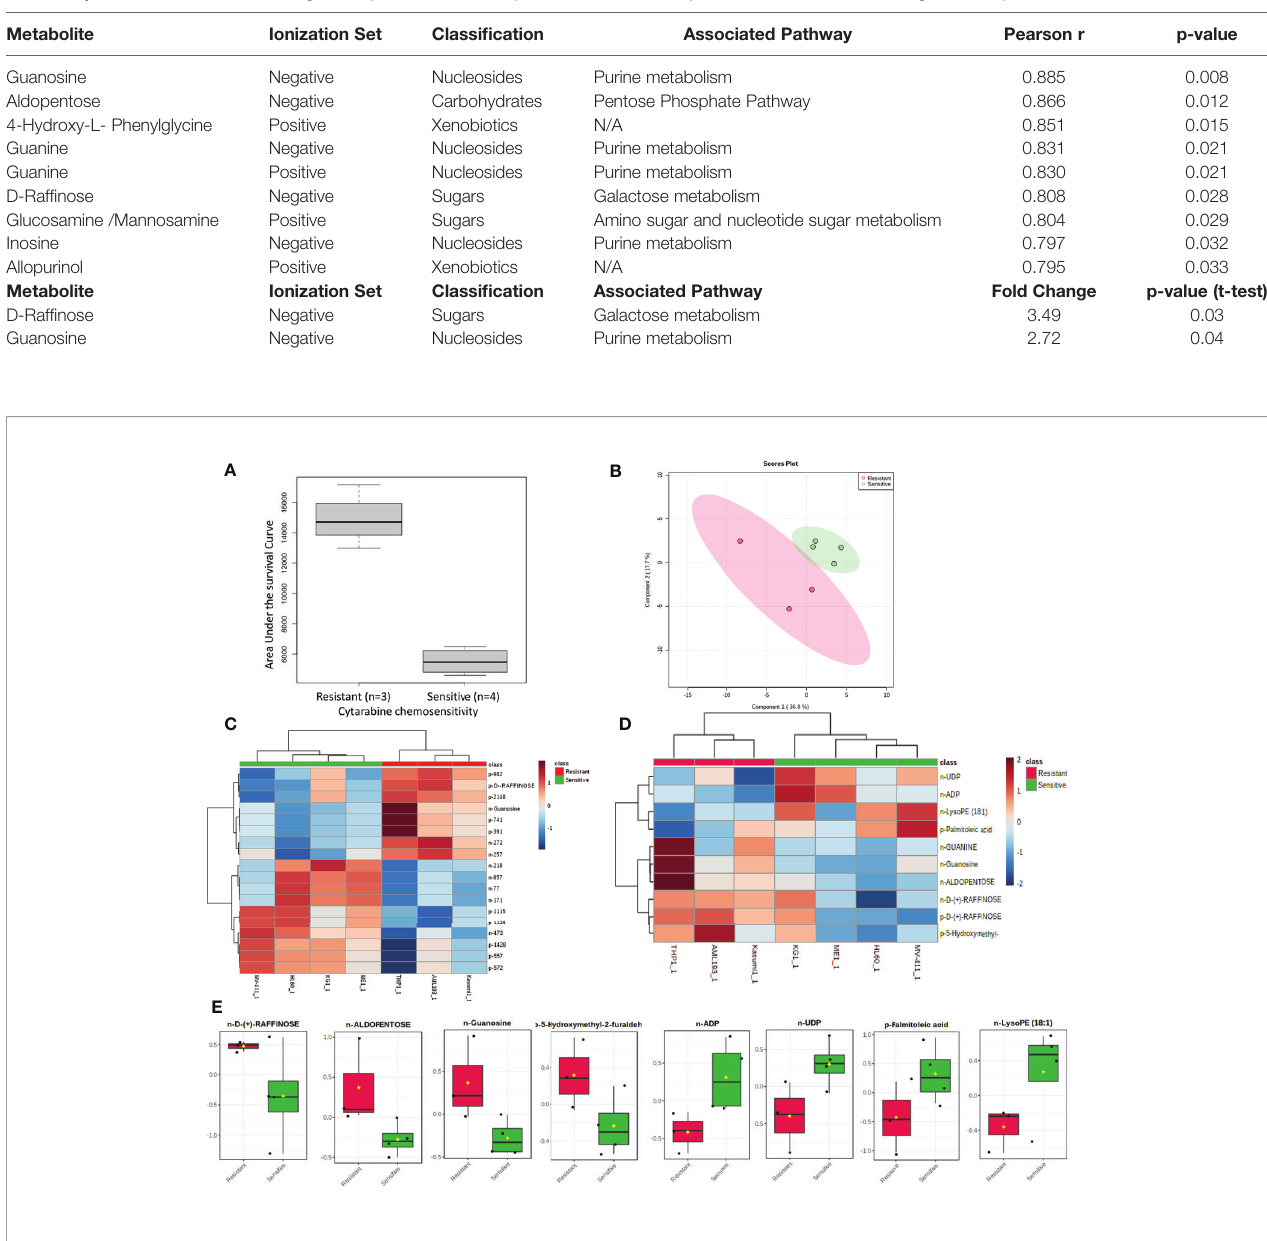
FIGURE 3 | Metabolome analysis by cytarabine in vitro chemosensitivity in AML cell lines. (A) Box plot showing differential AUC values between cytarabine sensitive and resistant cell lines. (B) Multivariate metabolomics analysis of AML cell line cytarabine chemosensitivity groups. (B) PLSDA plot of cell samples shows global separation by cytarabine chemosensitivity (Sensitive n=4 and Resistant n=3). (C) Clustering metabolomics analysis of AML cell line cytarabine chemosensitivity groups. Heatmap shows relative abundance patterns of 18 cell metabolites (annotated and un-annotated) with signi fi cantly different abundance between groups. Clustering within the heatmap shows a clear distinction of several metabolites between the sensitive and resistant groups. (D) Clustering metabolomics analysis of only annotated metabolites heatmap shows relative abundance patterns of top 10annotated cell metabolites with differential abundance between groups. (E) Box plots of selected metabolites showing abundance by drug sensitivity groups. p= positive and n=negative ionization